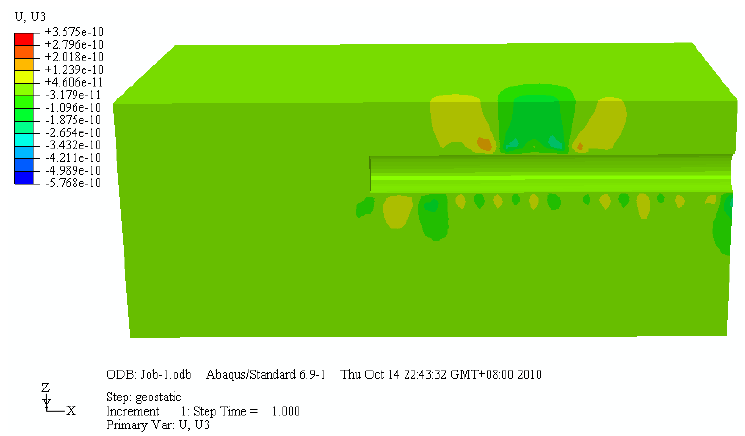
Figure 11. Vertical ground movement clouds of the initial state (m).